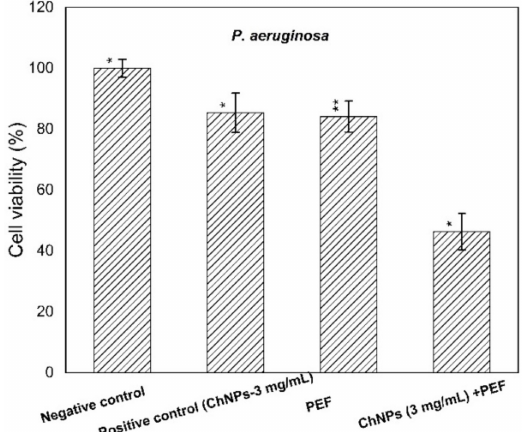
Figure 3. Cell viability percentages of P. aeruginosa relative to control bacterial counts. * statistically significant, ** statistically highly